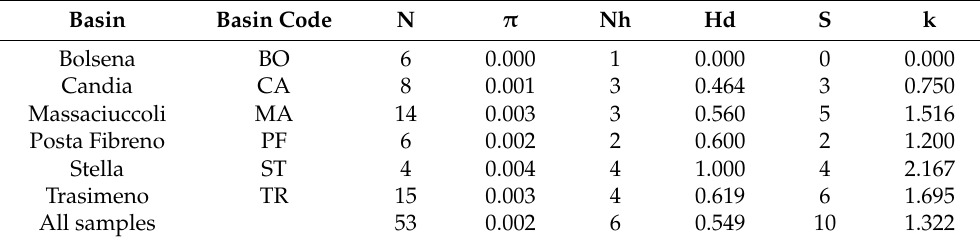
Table 2. Estimates of mtDNA COI genetic diversity indexes for all basins here analyzed (N = number of samples; π = nucleotide diversity; Nh = number of haplotypes; Hd = haplotype diversity; S = number of polymorphic sites; k = Tajima’s average number of nucleotide differences).